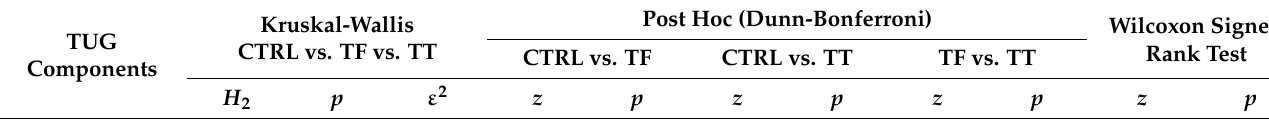
Table 4. Results of Kruskal–Wallis and Wilcoxon signed rank test